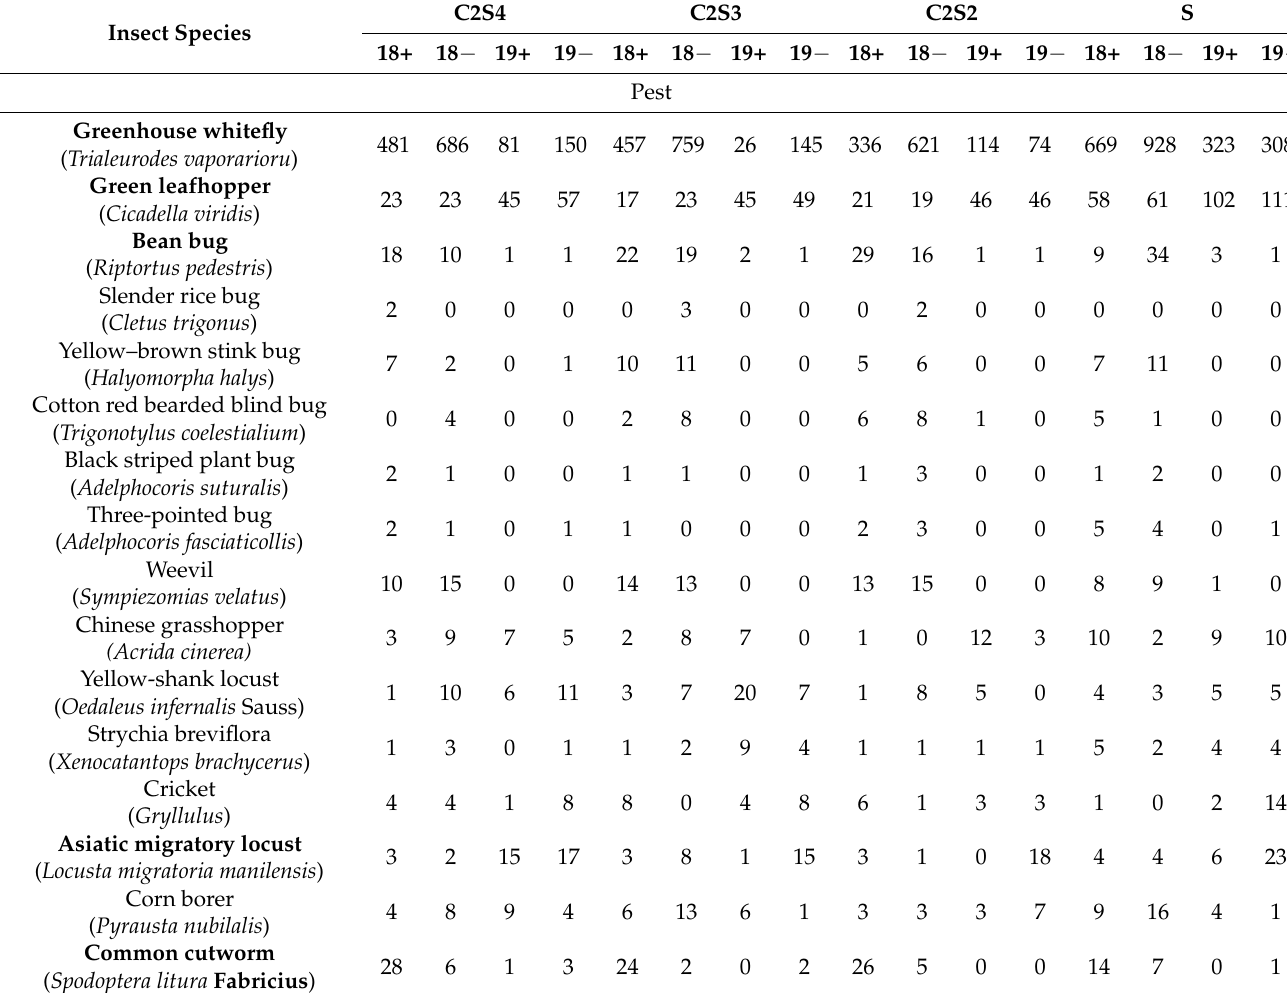
Table 5. The total number of main pests and natural enemies of insects was recorded in seven surveys per year under each